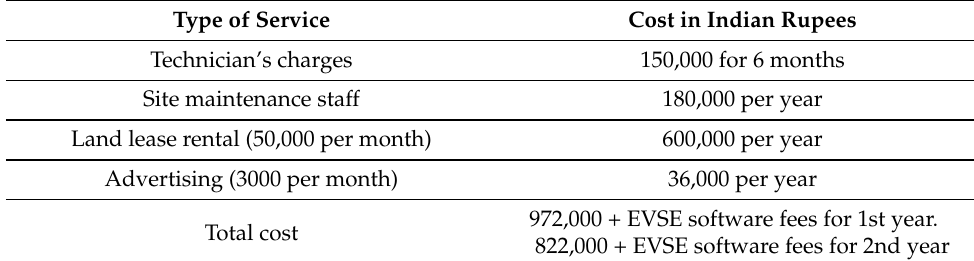
Table 4. OPEX: Cost estimation of the proposed multi-level charging